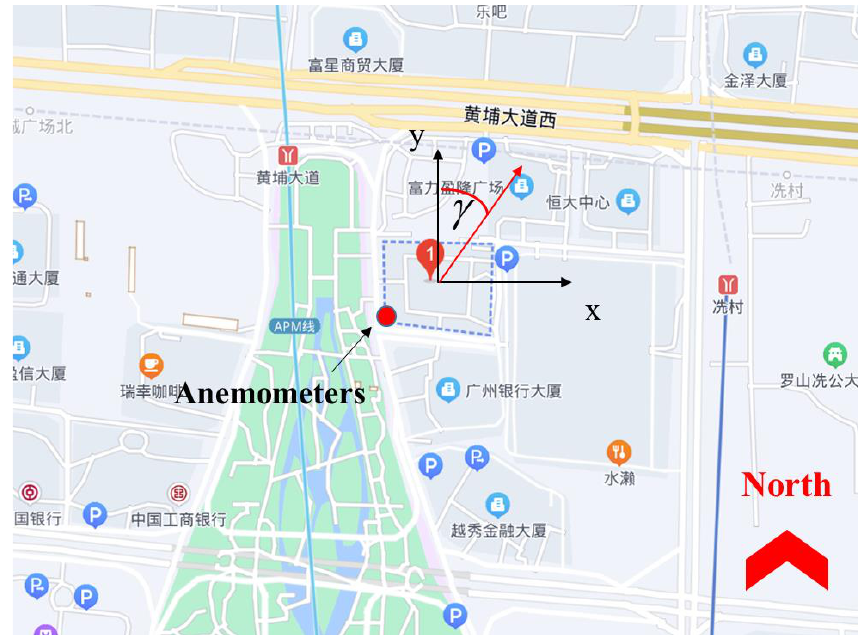
Figure 2. Measurement site location.